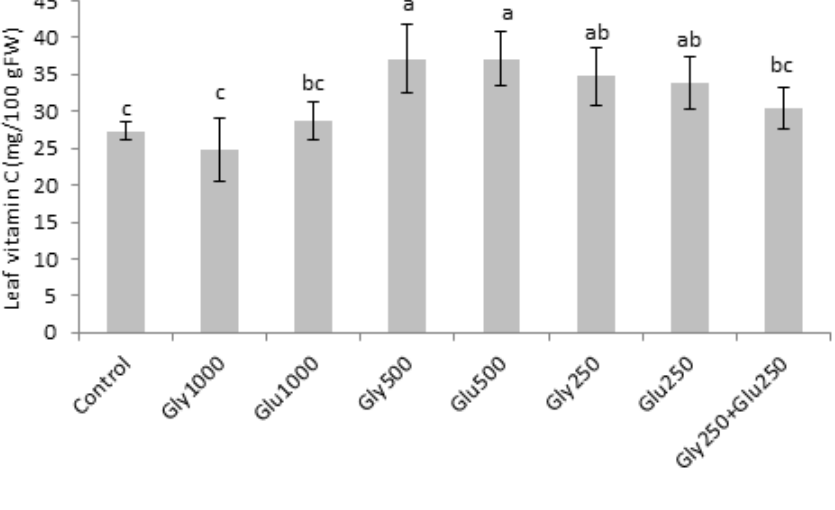
Figure 4: Leaf vitamin C concentration of lettuce plants under foliar application of glycine and glutamine amino acids. Data are average of four replications ± SD; comparison of means was done at 5% level of Duncan multiple ranges